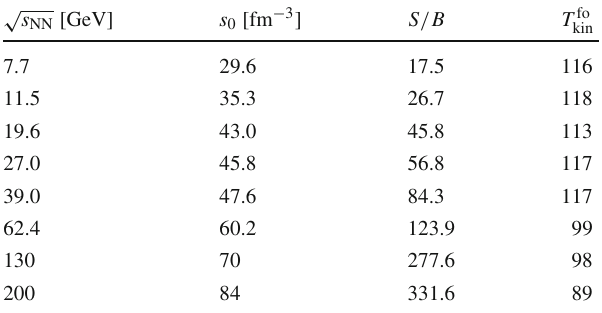
Table 4 Estimate of the initial entropy density and of the entropy per baryon in Au-Au collisions at different center-of-mass energies. We also quote the kinetic freeze-out temperature obtained in Refs. [16,25] through a